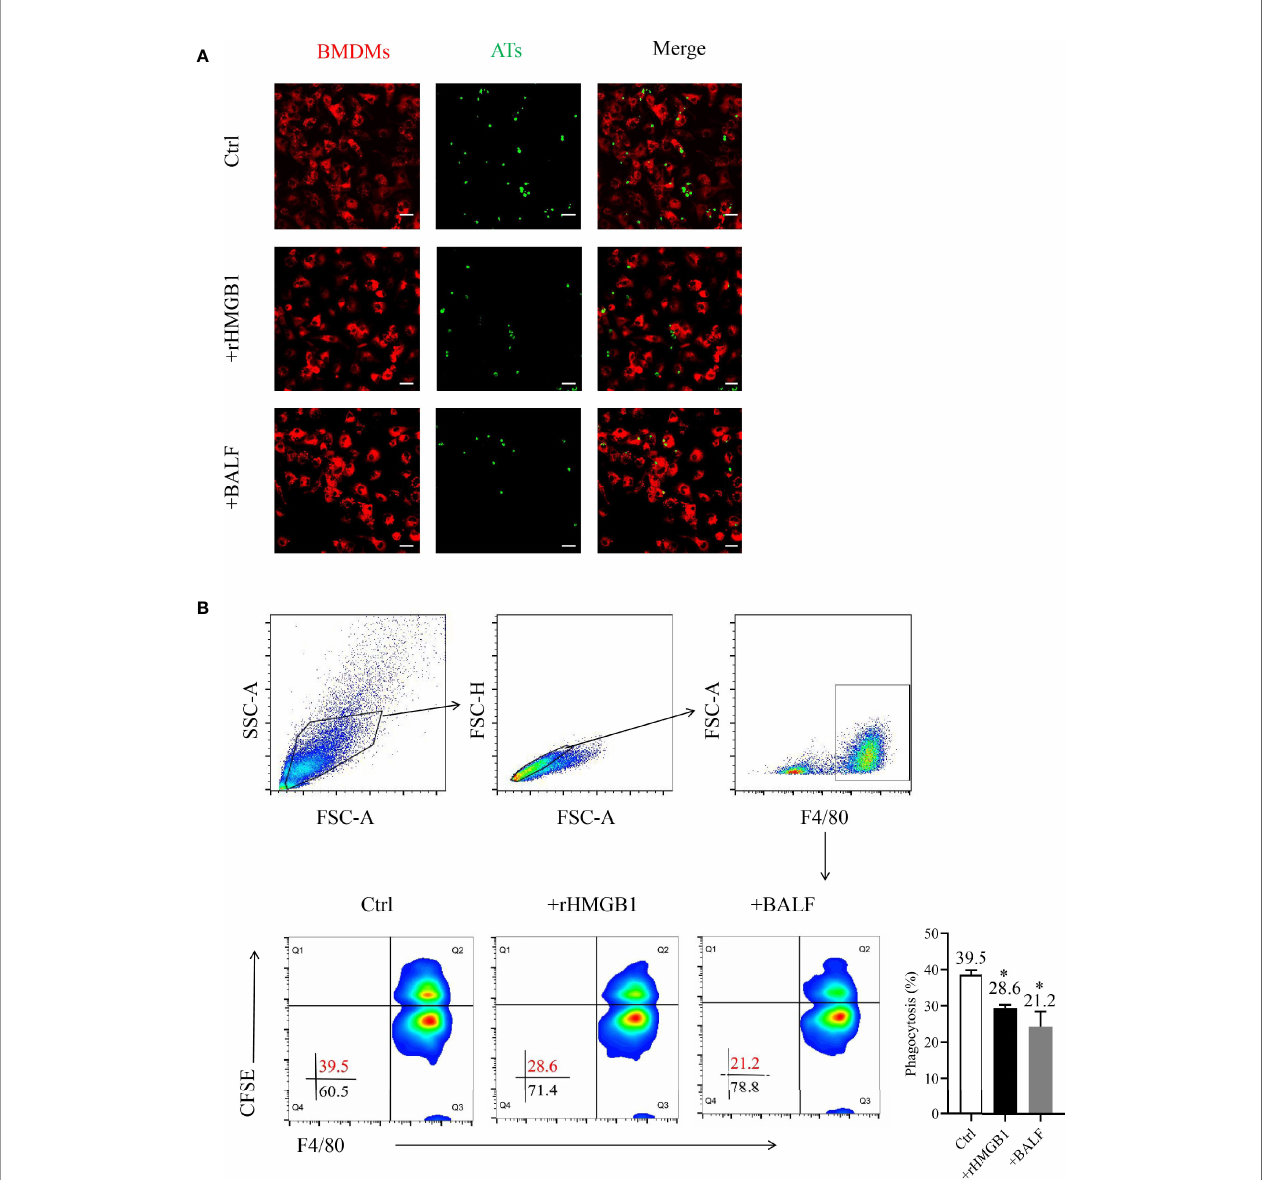
FIGURE 1 | Effects of recombinant HMGB1 (rHMGB1) treatment on macrophage-mediated efferocytosis. (A) Analysis of macrophage-mediated engulfment of apoptotic thymocytes (ATs) by confocal microscopy. The bone marrow-derived macrophages (BMDMs) were preincubated for 12 h with 2 m g/ml rHMGB1 or bronchoalveolar lavage fl uid (BALF) extracted from mice with acute lung injury (ALI). The CFSE-labeled ATs were co-cultured with Dil-labeled BMDMs for 2 h. The free and attached ATs were removed by extensive washing with cold phosphate buffered saline (PBS). Representative fl uorescence images of macrophage efferocytosis are shown in the left panel, and the numbers of ATs are shown in a bar graph in the right panel. Scale bars = 20.0 m m. (B) Analysis of the macrophage- mediated efferocytosis through fl ow cytometry. The F4/80-labeled BMDMs were pretreated as mentioned above and co-cultured with CFSE-labeled ATs (1:10) for 2 h. Representative images of the macrophages are shown in the left panel, and the phagocytosis rates are presented in the right panel. * P < 0.05 versus the wild- type (WT)